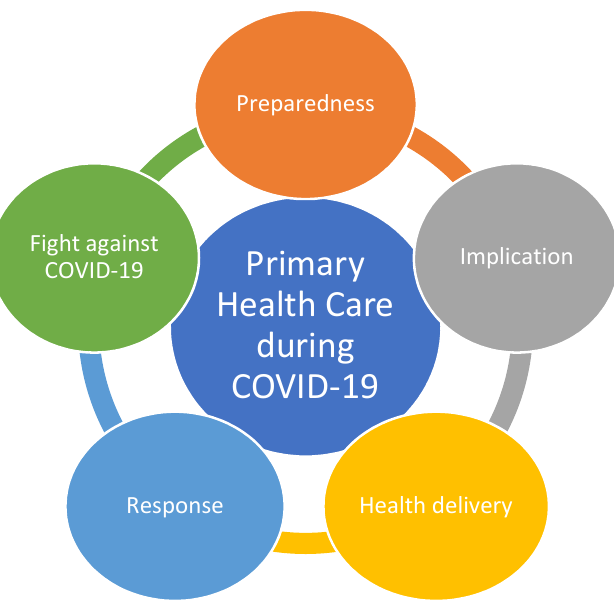
Figure 1. The five domains explored in the study describing the role of the Tunisian Primary Health Care in the management of the COVID-19 pandemic.